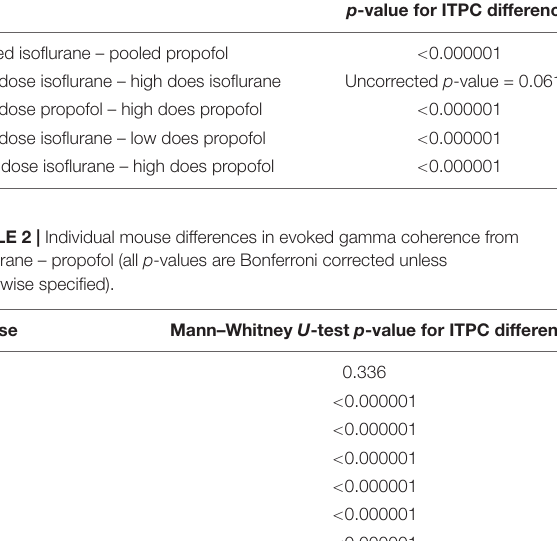
TABLE 1 | Difference in evoked gamma coherence across mice (all p -values are Bonferroni corrected unless otherwise specified). Comparison